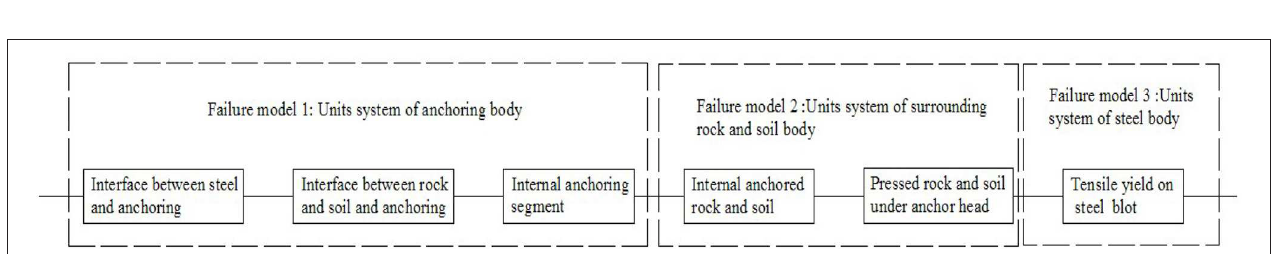
FIGURE 2 | Series model of the anchorage